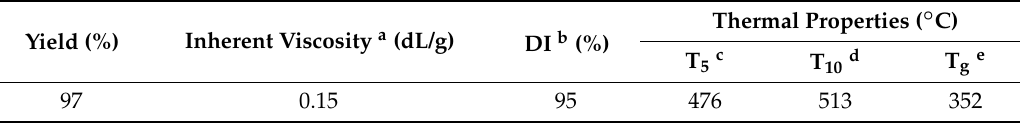
Table 1. Yield, viscosity, degree of imidization (DI), and thermal properties of PMDA-ODA synthesized in water.